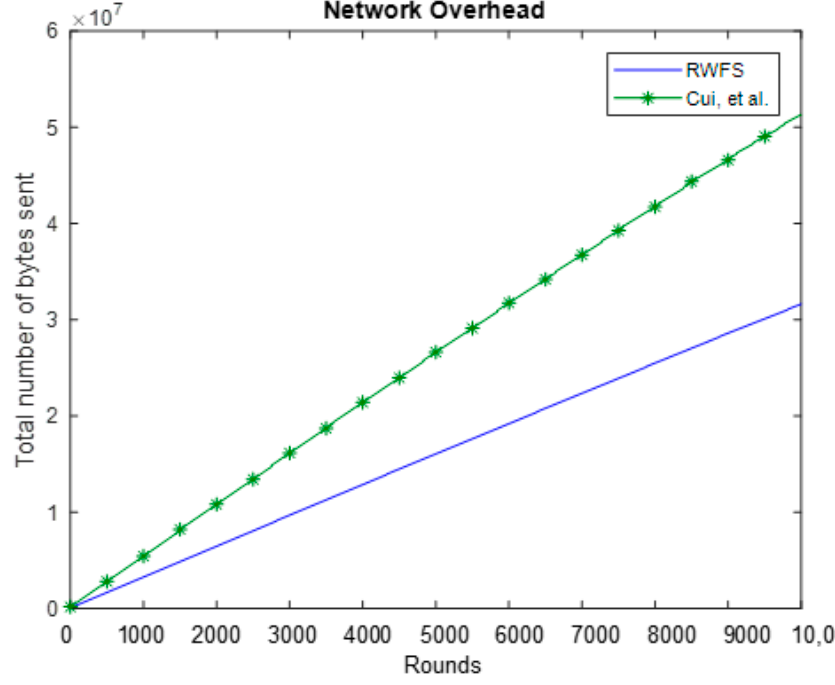
Figure 7. The network overhead analysis between RWFS (the proposed scheme) and the Cui et al. scheme. The two graphs show the total number of packets sent during 10,000 rounds.